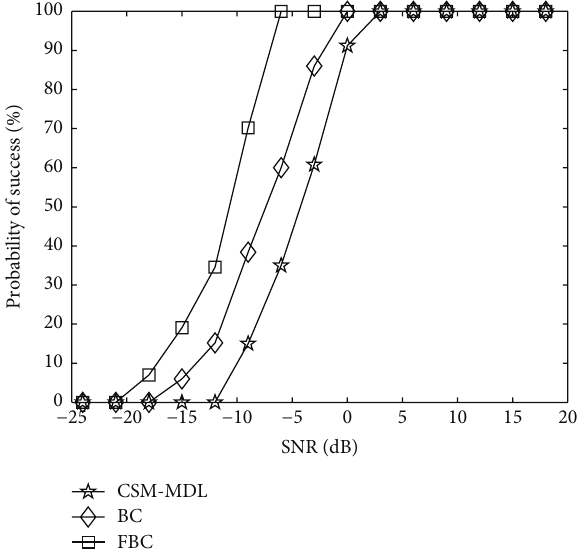
Figure 3: Probability of success versus number of snapshots for uncorrelated signals in Gaussian white